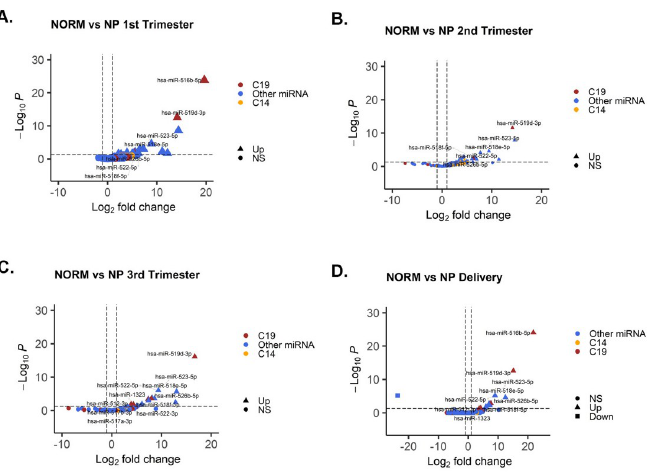
Fig 4. Pregnancy specific EV-derived miRNAs at three trimesters of gestation in normal pregnancy. Volcano plots show differential abundance of pregnancy-specific miRNAs from plasma EVs between non-pregnant (NP) and normal pregnancy (NORM) in (A) first, (B) second and (C) third trimesters of pregnancy and ( D ) at delivery. Filled circles represent no significant difference, triangles represent miRNA with upregulation and squares represent downregulation. Red denoting chromosome 19 microRNA clusters (C19MCs) while yellow denoting chromosome 14 microRNA clusters (C14MCs) and other non-C19MC or non-C14MC miRNAs are represented in blue.